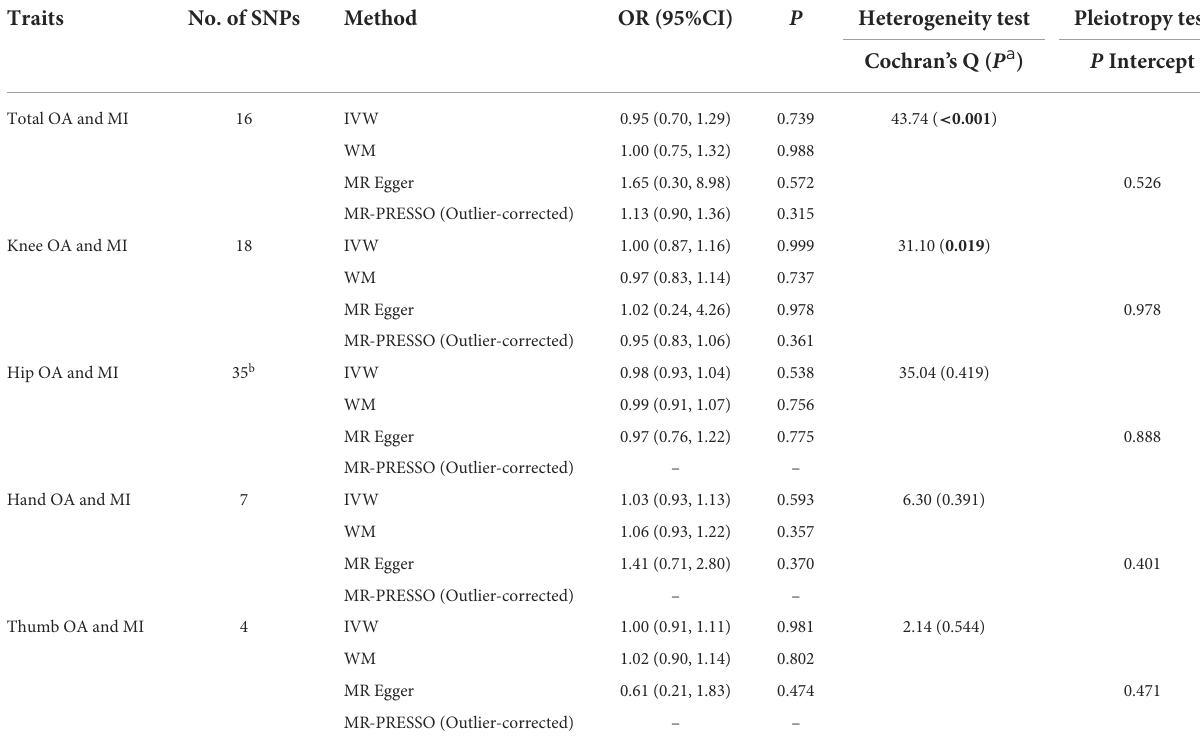
TABLE 3 MR results of the association between OA and MI. Traits